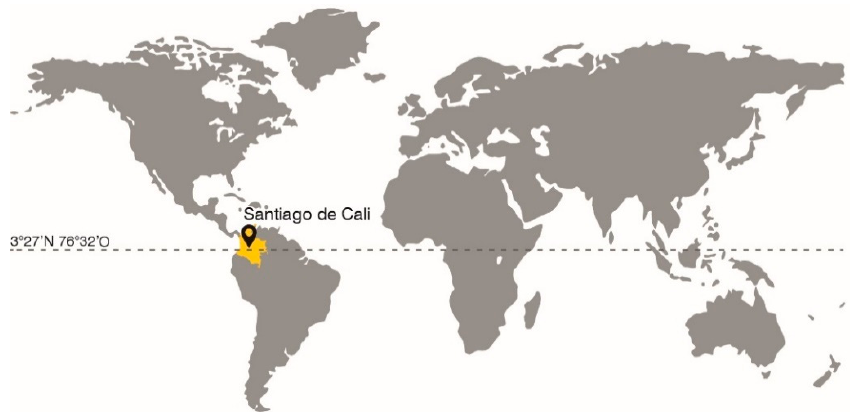
Figure 3. Location map of Santiago de Cali.